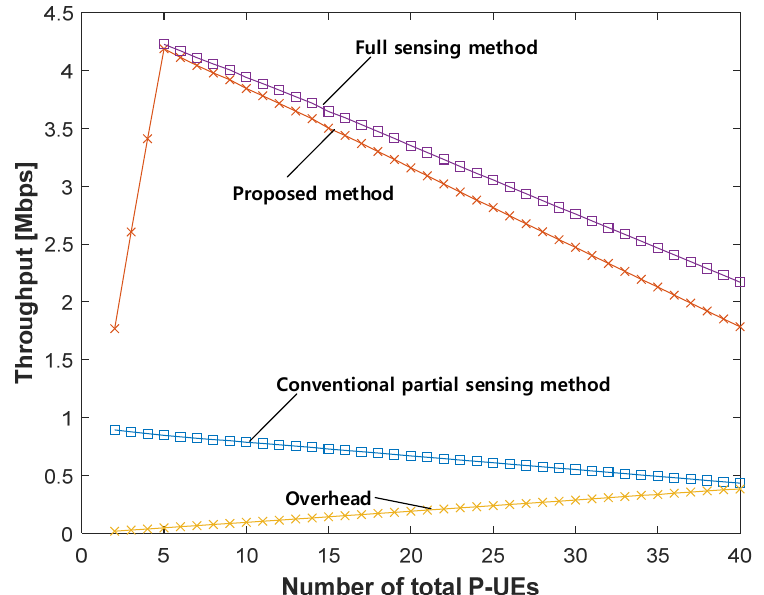
Figure 8. Throughput comparison and required overhead.